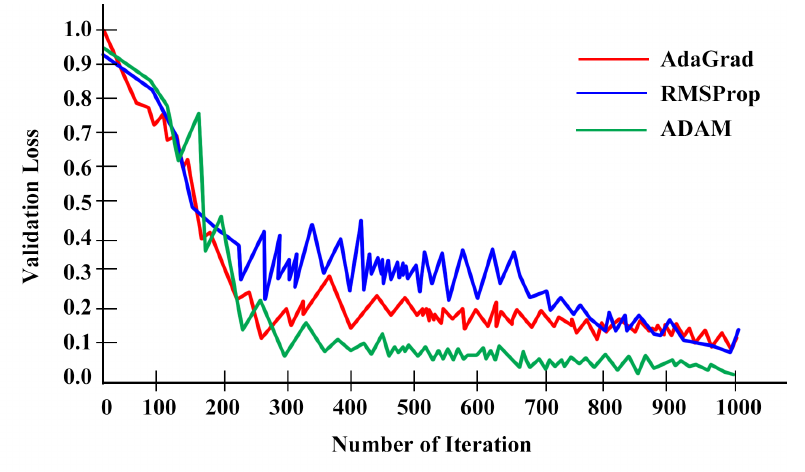
Figure 3. The optimization algorithm